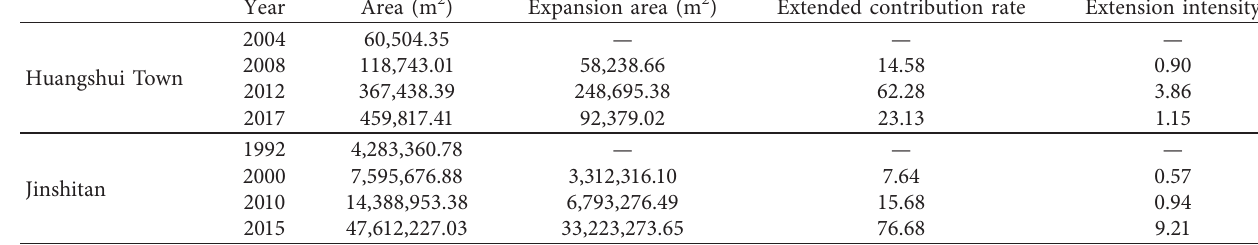
Table 2: Statistics on the growth of construction land area in tourism